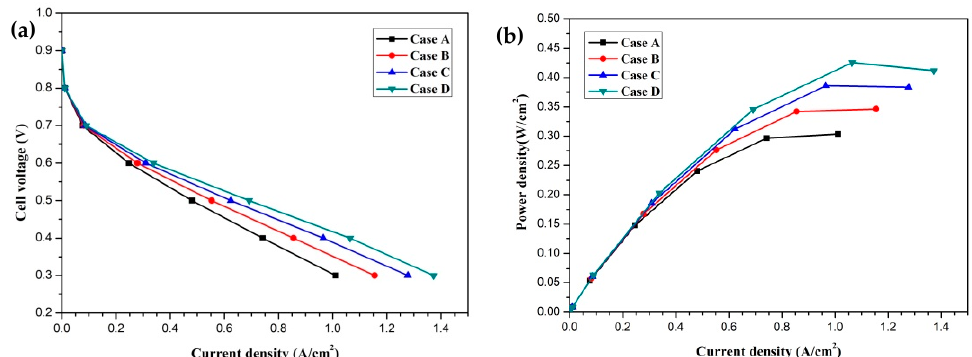
Figure 3. The cell performance of fuel cells with different membrane phosphoric acid doping levels (Case A: DL = 5; Case B: DL = 7; Case C: DL = 9; Case D: DL = 11): ( a ) cell voltage-current density curve; ( b ) power density-current density curve.